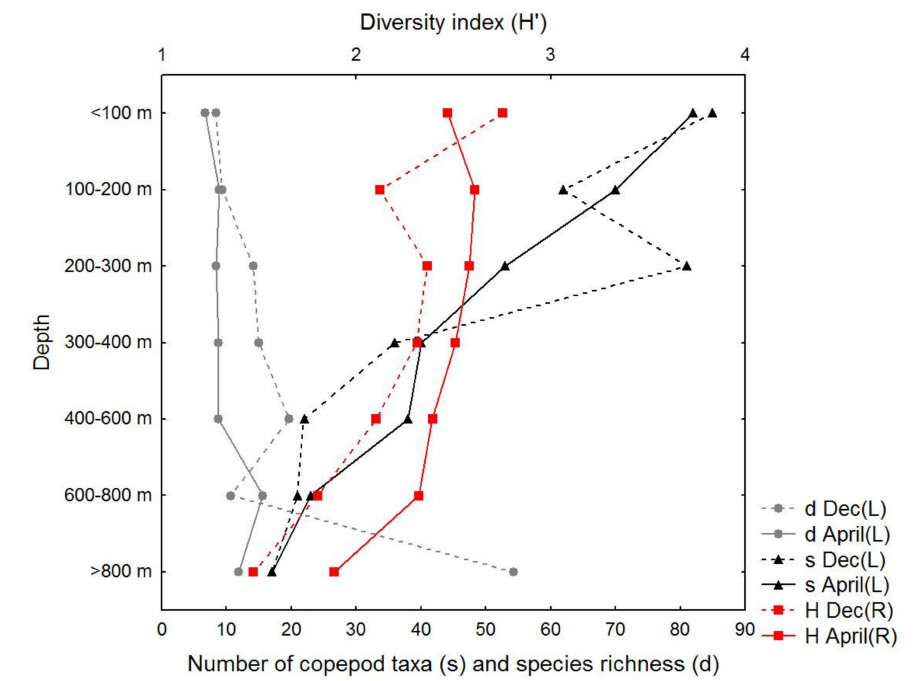
Figure 4. Vertical distribution of copepod diversity per sampling layer in December (dotted line) and April (solid line). S-number of taxa; H’-Shannon-Wiener diversity index, d-Margalef’s species richness. L: x -axis bottom; R: x -axis